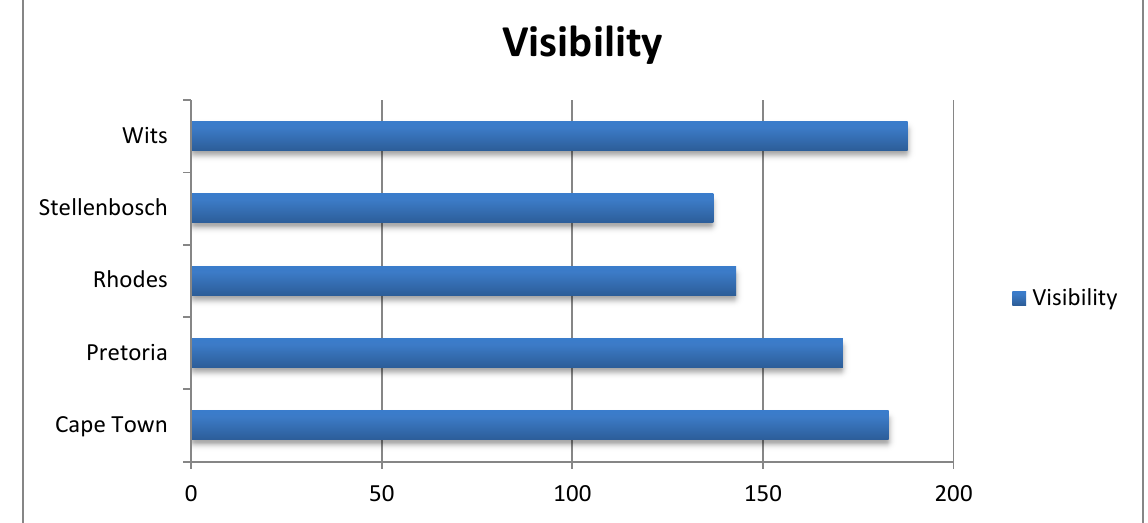
Figure 2: Overall visibility scores of the 5 university brands